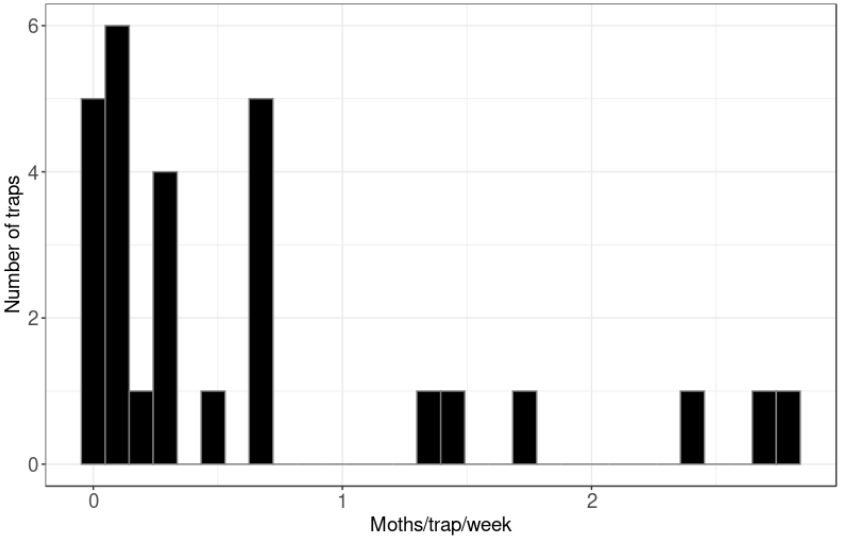
Figure 8. Distribution of the number of male codling moths ( Cydia pomonella ) caught in pheromone traps ( n = 28) in peri-urban Ongaonga.